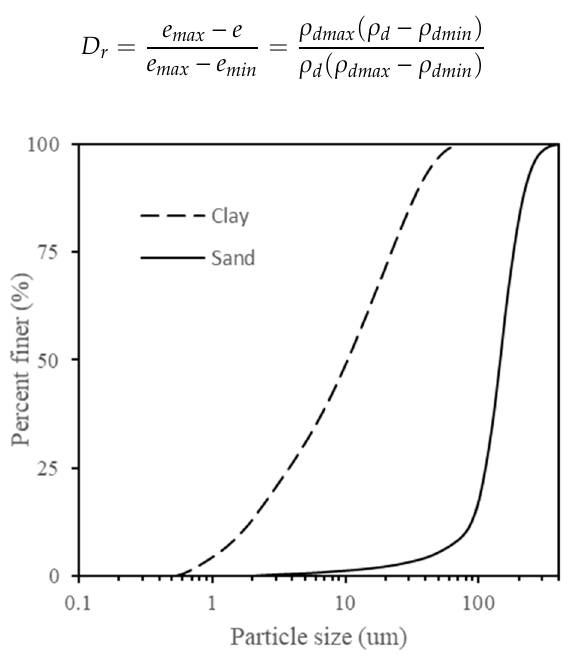
Figure 3. Particle size distributions of soil samples.